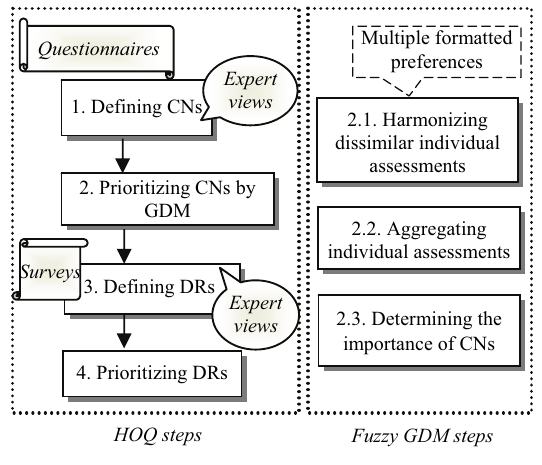
Fig. 2. Proposed Approach for QFD